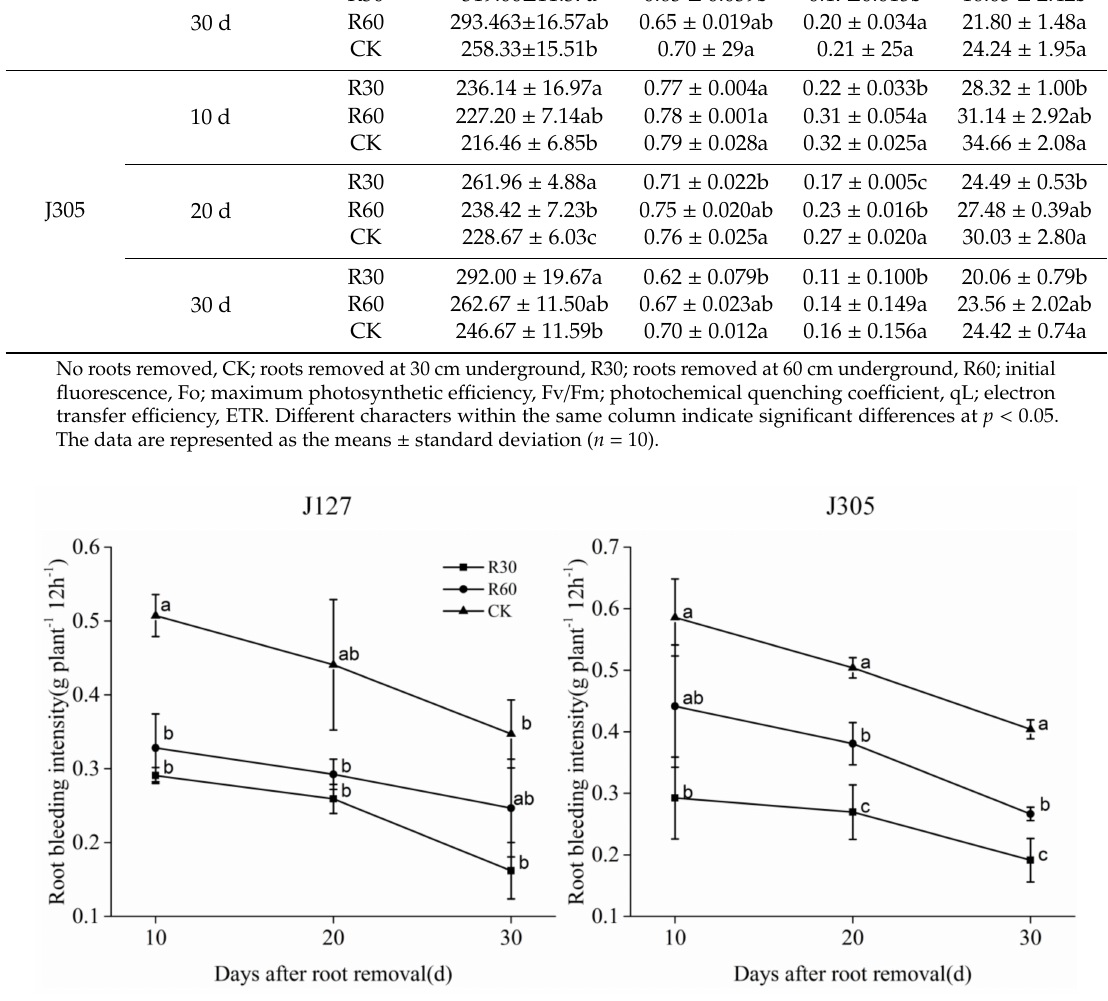
Figure 3. E ff ects of root removal in di ff erent soil depths on root bleeding intensity. No roots removed, CK; roots removed at 30 cm underground, R30; roots removed at 60 cm underground, R60. Di ff erent characters at the same stage indicate significant di ff erences at p < 0.05. Vertical bars represent the standard deviation of three replications ( n =